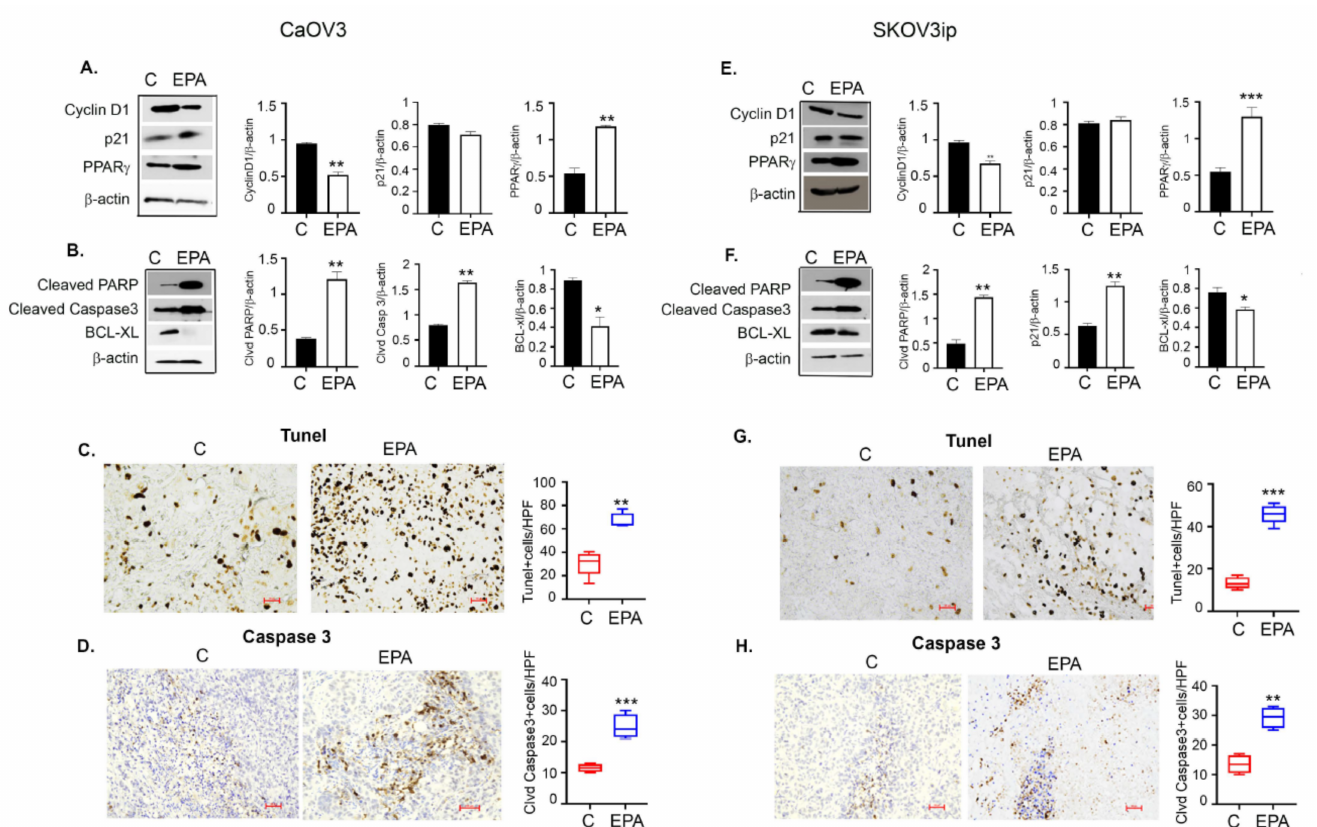
Figure 8. EPA treatment induces antiproliferative and apoptotic cell death in ovarian tumors. Pooled tumor tissue ( n = 4) was used to isolate protein and immunoblotted for various markers including cell cycle proteins cyclin D1 and p21, and proliferation promoter PPAR γ in ( A ) CaOV3 and ( E ) SKOV3ip tumors treated with EPA or vehicle. Bar graph represents normalized densitometric expression, n = 2. Uncropped Western blot images are shown in Figure S9. Immunoblots showing expression patterns of apoptotic markers cleaved PARP and cleaved caspase 3 in ( B ) CaOV3 and ( F ) SKOV3ip tumors treated with EPA or vehicle. Bar graph represents normalized densitometric expression, n = 2. Uncropped Western blot images are shown in Figure S9. Representative IHC images (200 × ) showing TUNEL stain in CaOV3 ( C ) and SKOV3ip ( G ) tumors. Box-plots show the number of positive cells per field calculated from n = 5 images per group at HPF. Representative IHC images showing cleaved caspase 3 stain in CaOV3 ( D ) and SKOV3ip ( H ) tumors. Box-plots show the number of positive cells per field calculated from n = 5 images per group at HPF. * p ≤ 0.05, ** p ≤ 0.01, and *** p ≤ 0.001, EPA-treated group compared to vehicle-treated